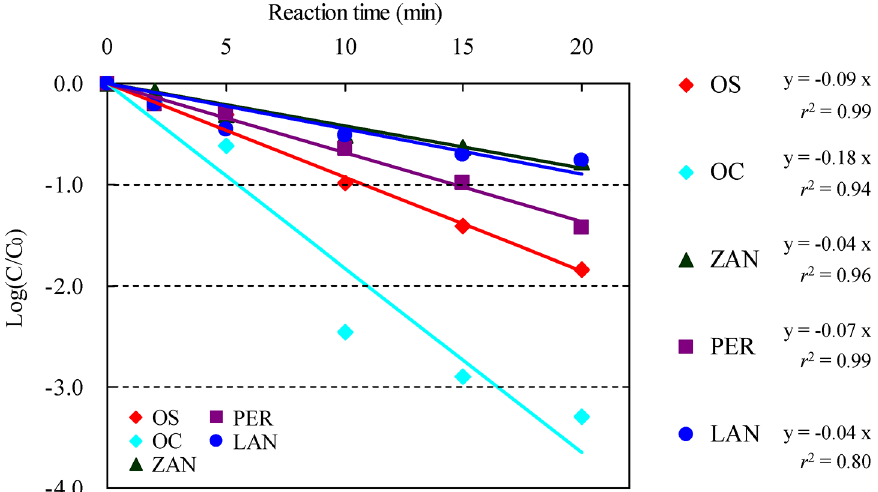
Fig 3. Relative residual concentrations of OS, OC, ZAN, PER, and LAN after experimental ozonation of secondary effluent from an STP at the influenza peak (C 0 : Initial concentration, C: Concentration after